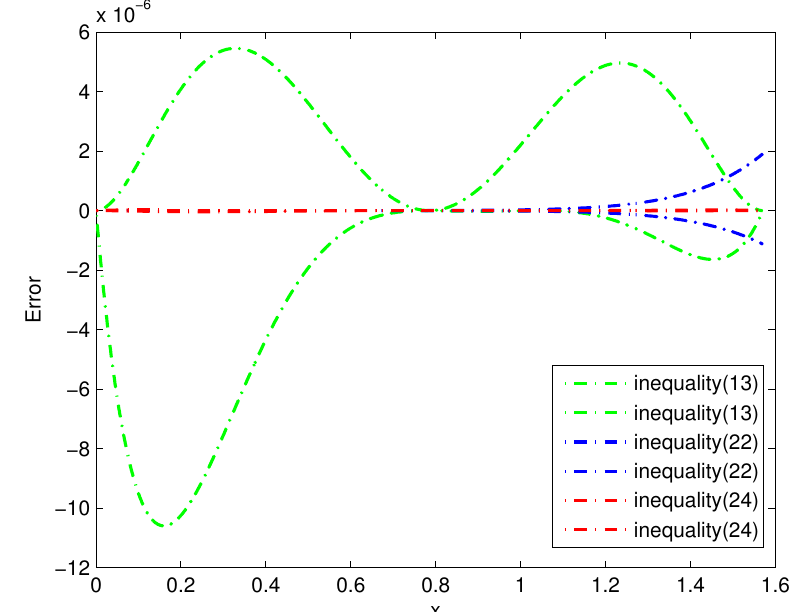
Figure 1. Error plots between sinc ( x ) and the bounds of Inequality (13), Inequality (22), and Inequality